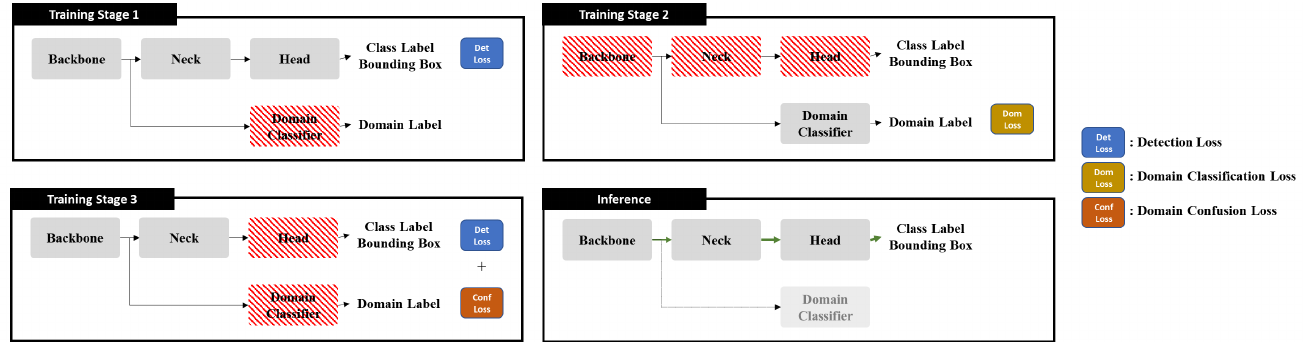
Figure 3. Three training stages of the proposed framework. Modules painted in red stripes denote frozen layers, where model weights are not updated during the stage. Loss elements used to calculate gradients are denoted at each